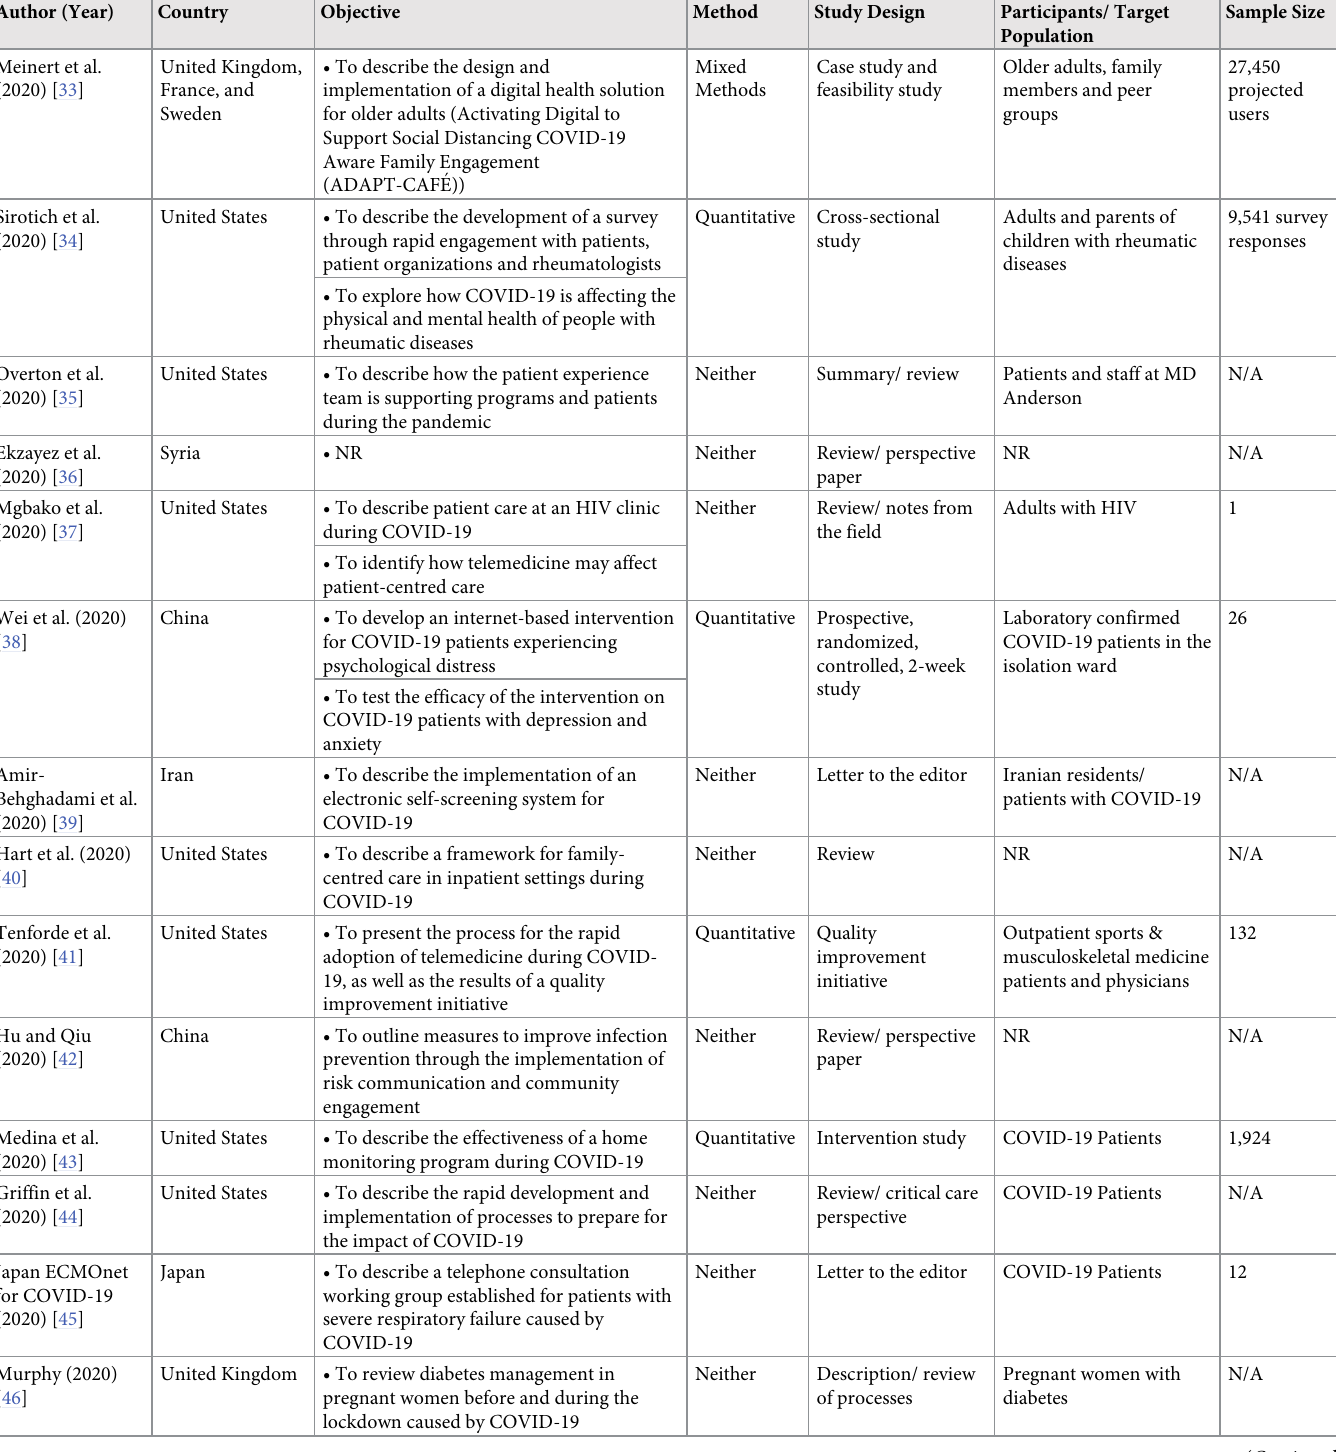
Table 1. Characteristics of included articles (n =